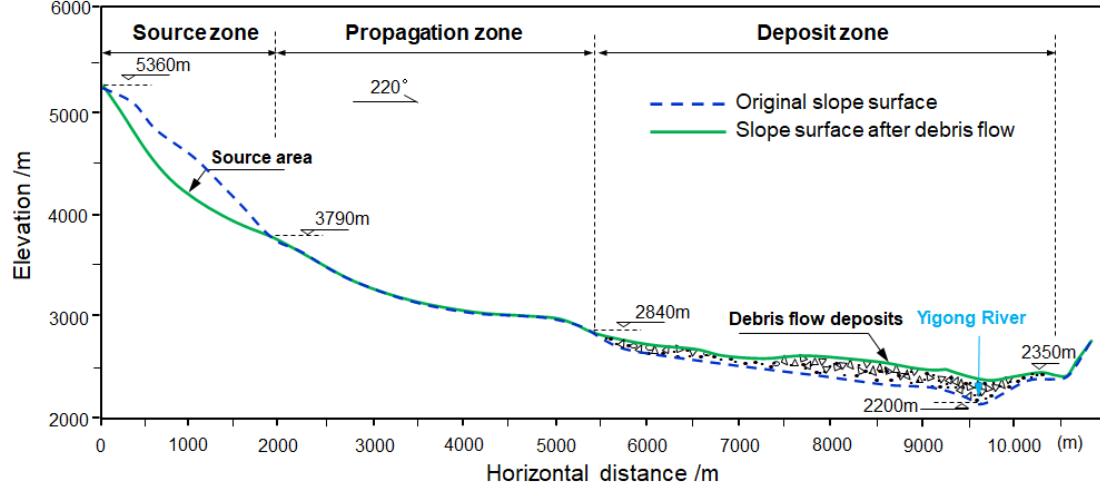
Figure 4. Path profile of the Yigong debris flow (based on [42]).